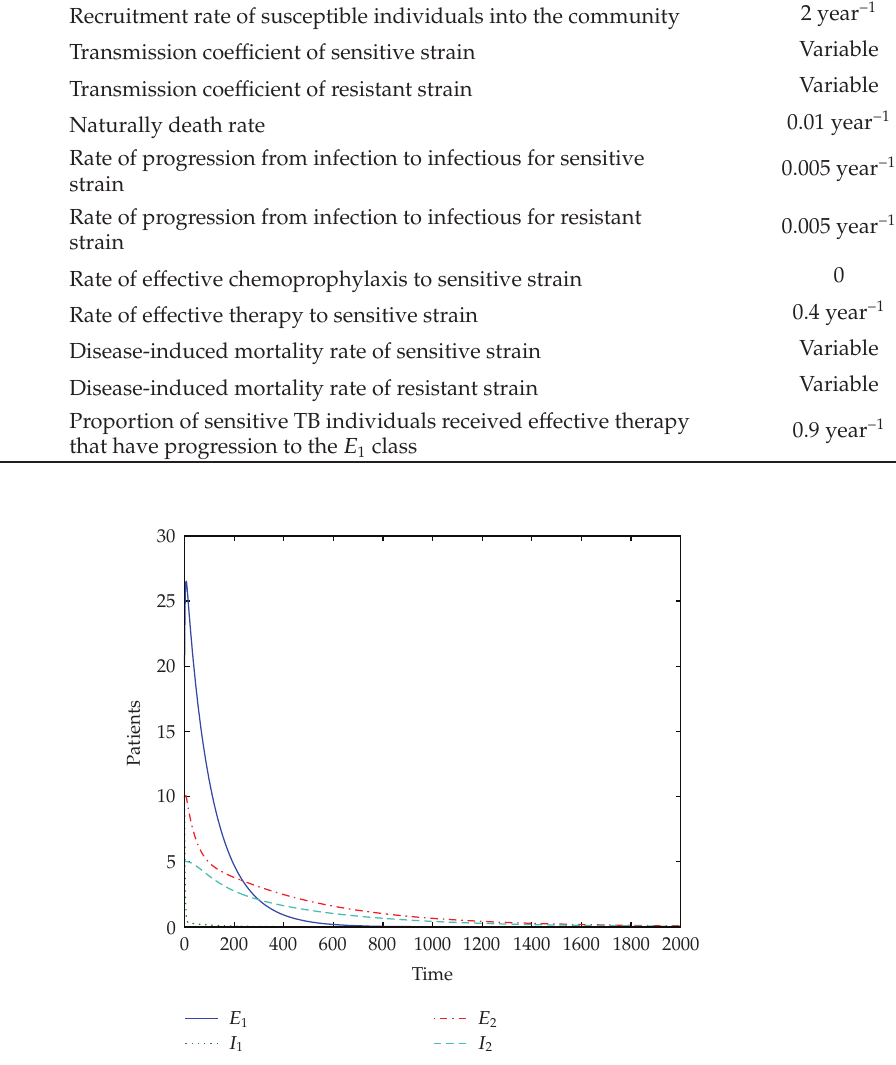
Figure 2: Trajectories of system (cid:2) 2.2 (cid:3) when β 1 (cid:2) N (cid:3) (cid:8) β 1 , β 2 (cid:2) N (cid:3) (cid:8) β 2 , β 1 (cid:8) 0 . 001, β 2 (cid:8) 0 . 0001, d 1 (cid:8) d 2 (cid:8) 0, so that R 1 < 1, R 2 < 1. It shows that the disease-free equilibrium P 0 is stable. β 2 (cid:2) N (cid:3) (cid:8) β 2 /N and β 1 (cid:2) N (cid:3) (cid:8) β 1 C (cid:2) N (cid:3) , β 2 (cid:2) N (cid:3) (cid:8) β 2 C (cid:2) N (cid:3) , C (cid:2) N (cid:3) (cid:8) bN/ (cid:2) 1 (cid:9) bN (cid:9)